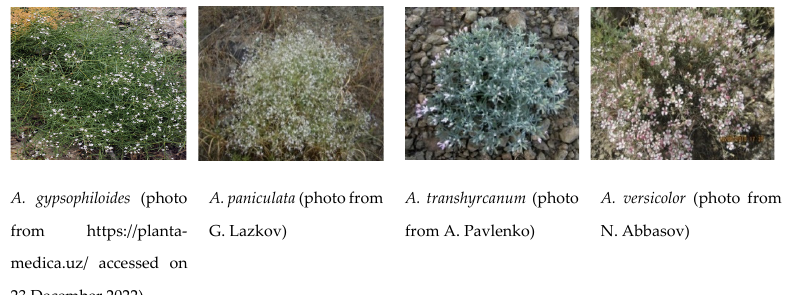
Figure 1. Photos of some Allochrusa species (https://www.plantarium.ru/lang/en/page/view/item/43196.html/, accessed on 23 December 2022) . In Uzbek flora, Allochrus a is described by three species: Allochrusa gypsophiloides (syn.